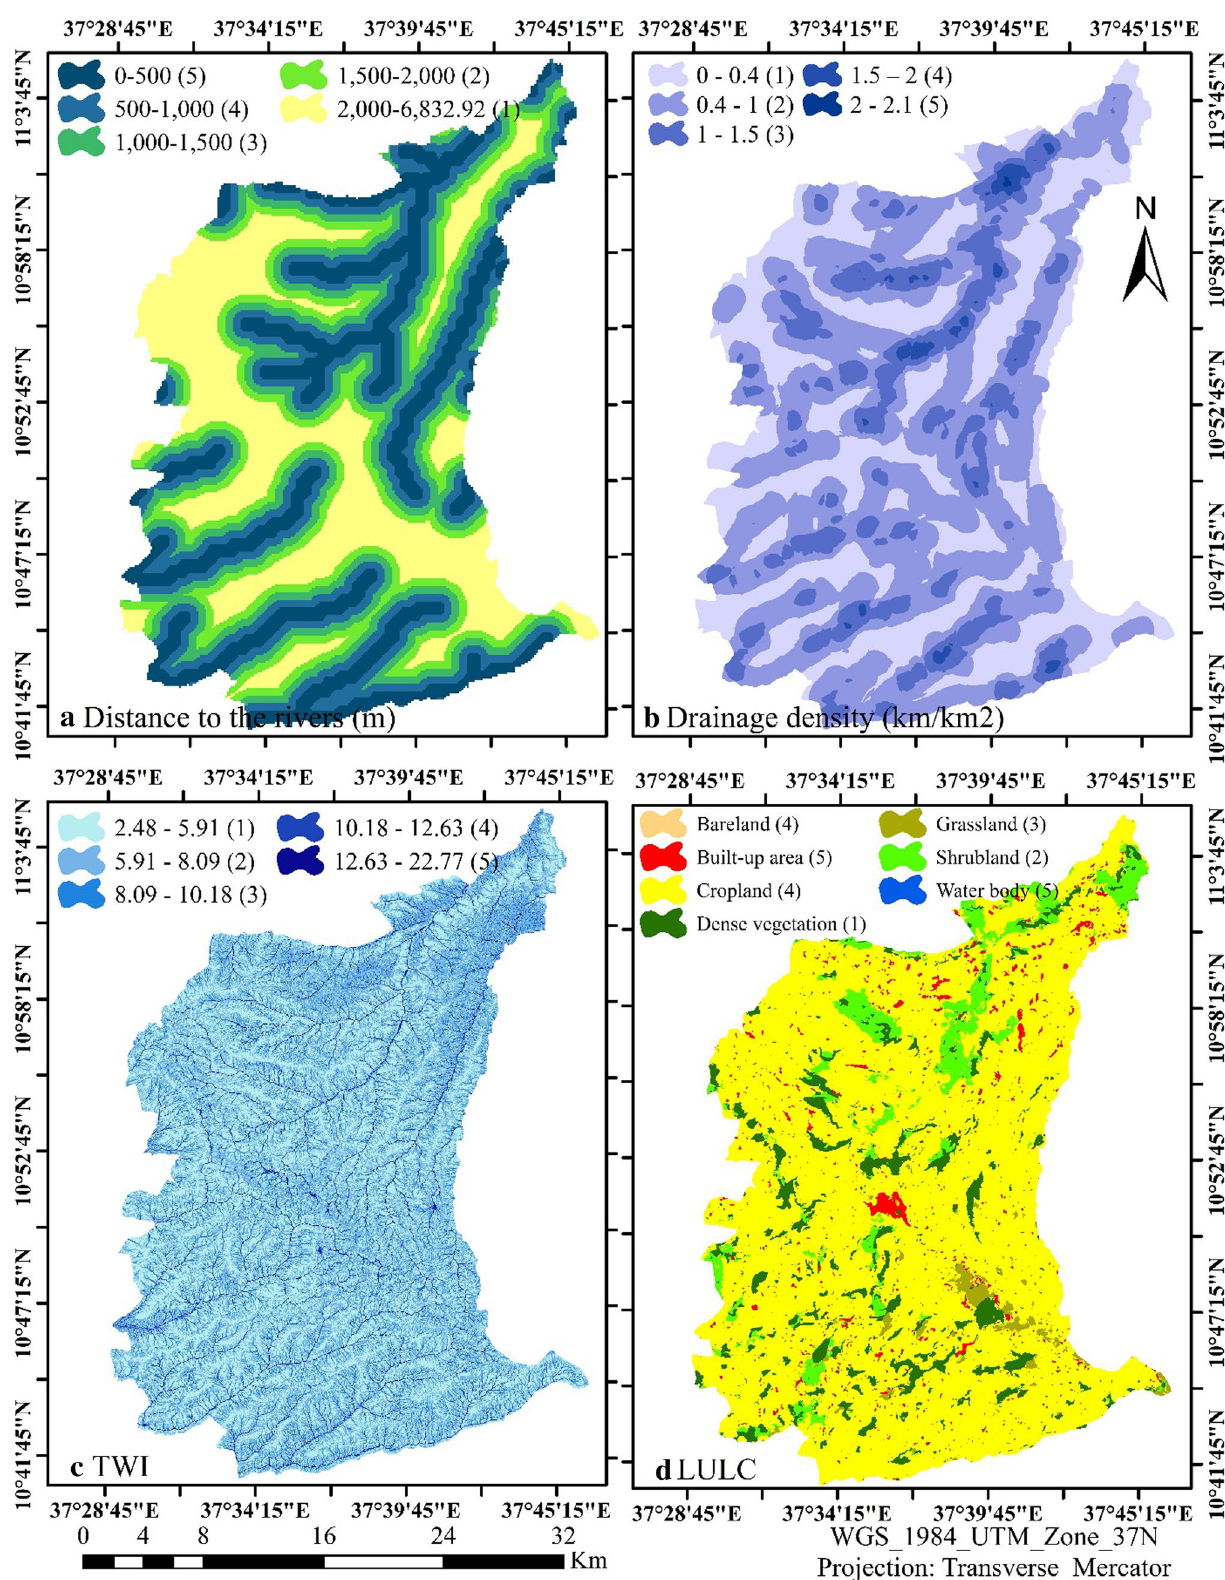
Fig. 4 Distance from the rivers a , drainage density b , Topographic Wetness Index c , and land use/land cover d factor